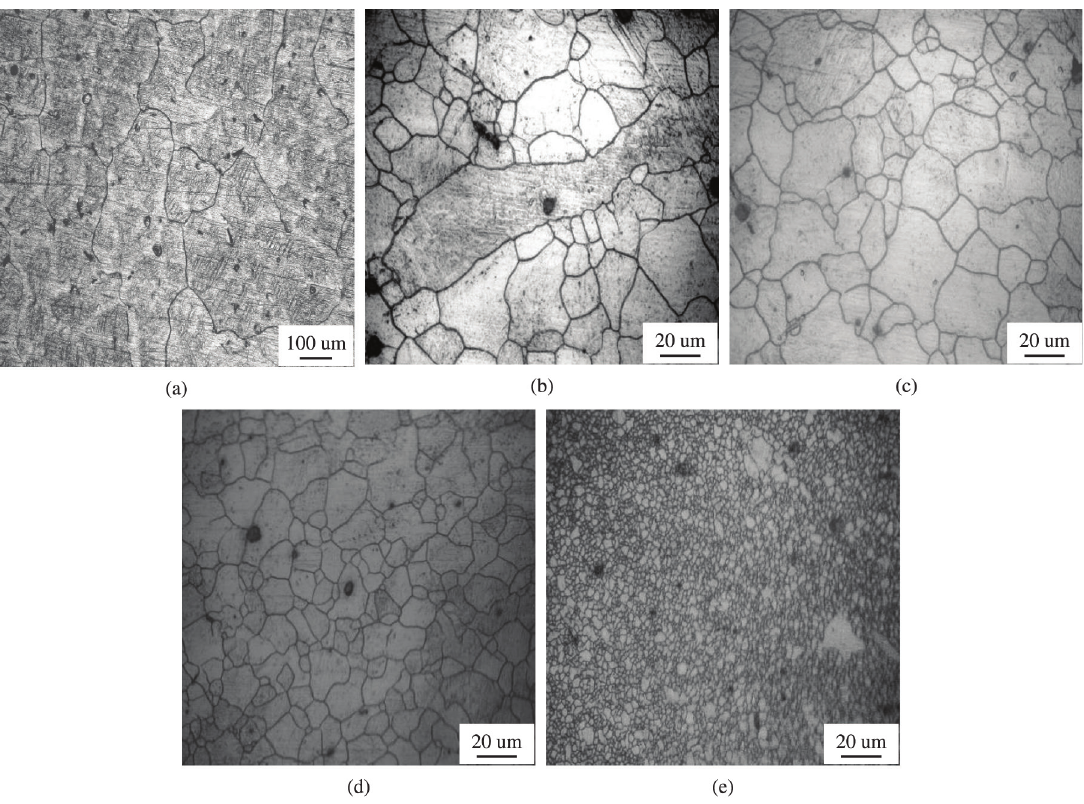
Figure 9. Microstructures for as-received AZ31 alloy (a) and microstructures in different parts of ES die, (b) reducing zone, (c) sizing zone, (d) the first shear step and (e) the second shear